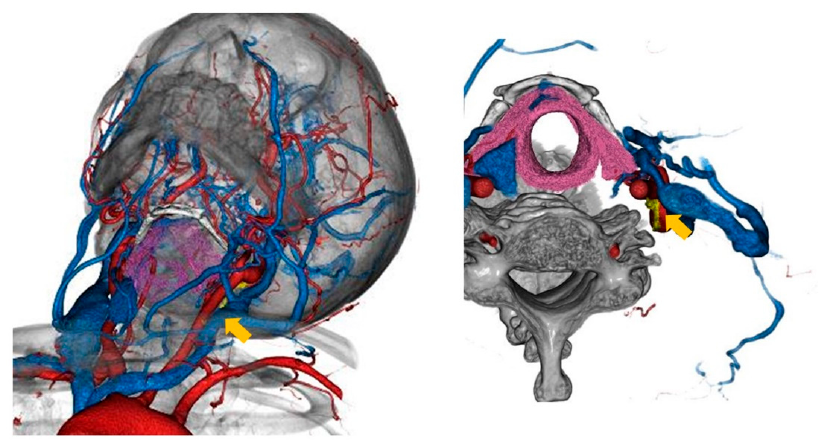
Figure 2. The visualized vagus nerve and its anatomical relationship with CCA and IJV in case 2. The vagus nerve was colored yellow (arrow).